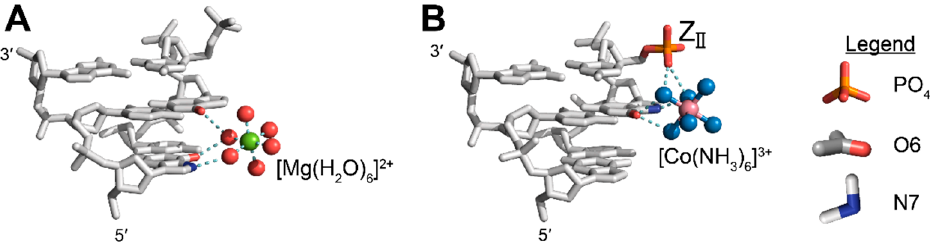
Figure 10. Examples of direct ion binding to Z-DNA. ( A ) A hydrated magnesium binds to the major groove surface of a d(CpG) step, forming three hydrogen bonds between two interstrand guanines (PDB: 1DCG [117]). Guanine O6 and N7 of one strand and guanine O6 of the opposite strand are bridged. ( B ) Cobalt hexammine directly binds to one strand of a d(CpG) sequence, forming 5 hydrogen bonds (PDB: 331D [118]). Two N2 groups hydrogen bond to OP2 of a Z II phosphate, two N2 groups hydrogen bond to guanine O6, and another N2 group hydrogen bonds to N7 of the same guanine. Cobalt hexammine stabilization appears to be specific to Z-DNA and not Z-RNA.